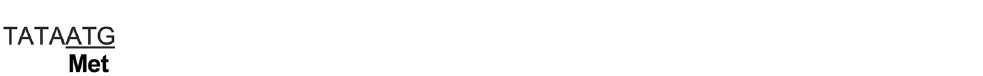
Figure 3. RovM represses hmsHMSF expression directly. ( a,b ) RovM repress the expression of the hms operon. The β -galactosidase activity ( a ) or relative expression measured by quantitative RT-PCR ( b ) in the indicated bacterial strains was determined. ( c ) RovM binds the hmsHFRS promoter. Biotin-labelled probe, unlabelled probe or an unrelated fragment was incubated with RovM [0, 0.13, 0.27, 0.54 and 0.108 µ M] or BSA [5 µ M]. The protein-DNA complexes were detected by streptavidin- conjugated HRP and chemiluminescent substrate. Unlabelled promoter was added to determine the binding specificity of RovM. Bio-P hmsHFRS : biotin-labelled hmsHFRS promoter; P hmsHFRS : unlabelled hmsHFRS promoter; URD: unrelated fragment (uncropped version was shown in Fig. S4b). ( d ) Identification of the RovM-binding site within the hmsHFRS promoter using a DNase I footprinting assay. ( e ) Nucleotide sequences of the hmsHFRS promoter region. Putative − 35 and − 10 elements of the hmsHFRS promoter are boxed. + 1 denotes the transcription start point. The RovM-binding sites identified using the DNase I footprinting assays are indicated by shading. ( f ) Aggregates formed in WT, Δ rovM , Δ rovM Δ hmsHFR and Δ rovM ( rovM ) grown in M9 to the late exponential phase. Data are presented as the mean values ± SD calculated from three sets of independent experiments. * P < 0.05; n.s., not